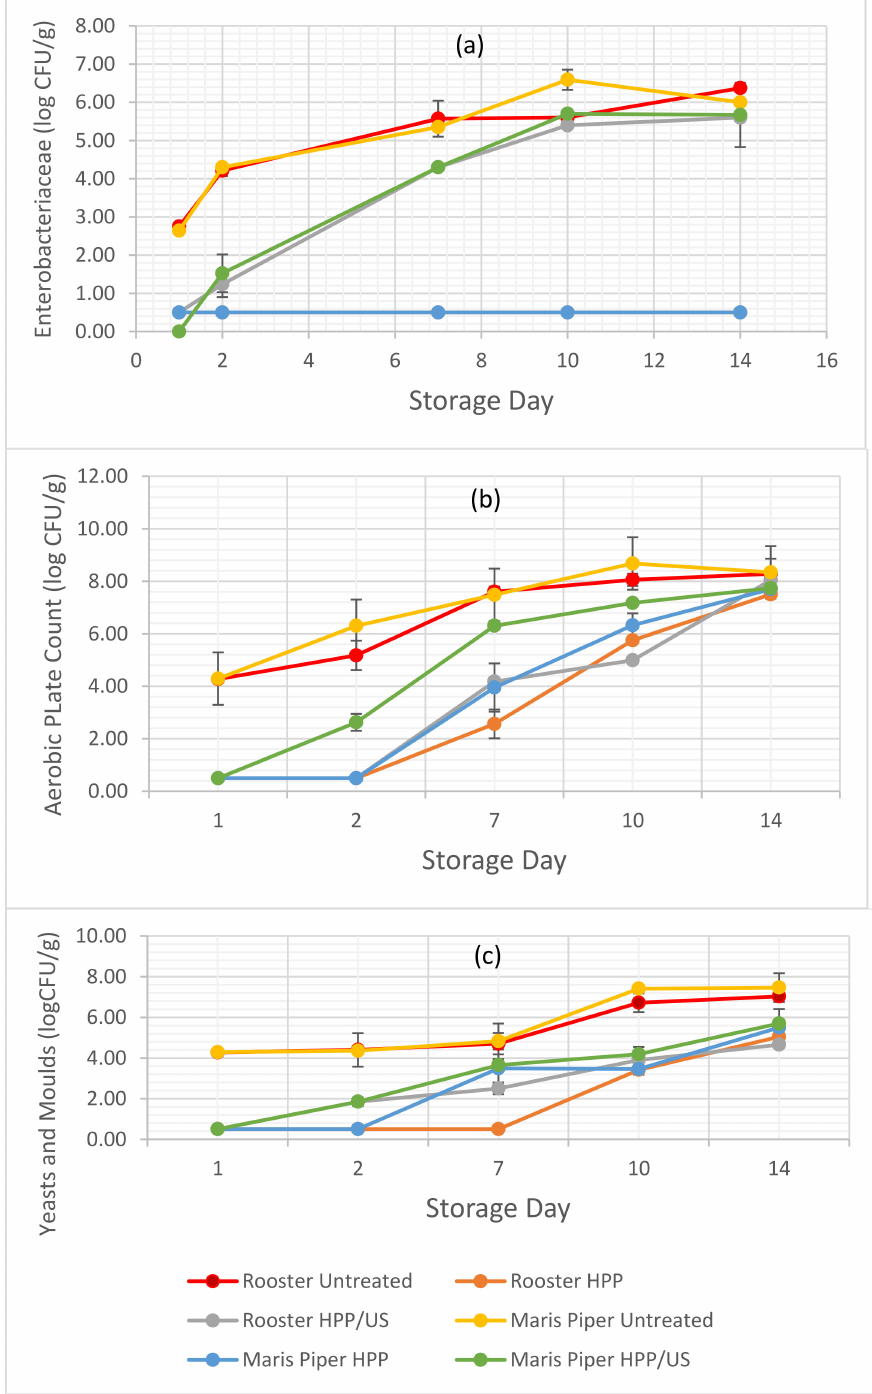
Figure 1. Effect of HPP and HPP/US on Enterobacteriaceae ( a ), aerobic plate count ( b ) yeasts and moulds ( c ) in minimally processed potatoes of the Maris Piper and Rooster cultivars during storage. Enterobacteriaceae were not detectable in the HPP-treated samples of both potato cultivars. Although HPP followed by US slowed down the growth of these microorganisms, it did not have a significant ( p > 0.05) effect on them by the end of the storage period when compared to the untreated samples. Similarly, there was a significant ( p < 0.05) retardation of the aerobic plate count (APC) in HPP- and HPP/US-treated samples of both cultivars until the 10th day of storage. In fact, HPP/US-treated Rooster samples had significantly lower APC than the controls and the HPP-treated samples until the 10th day of